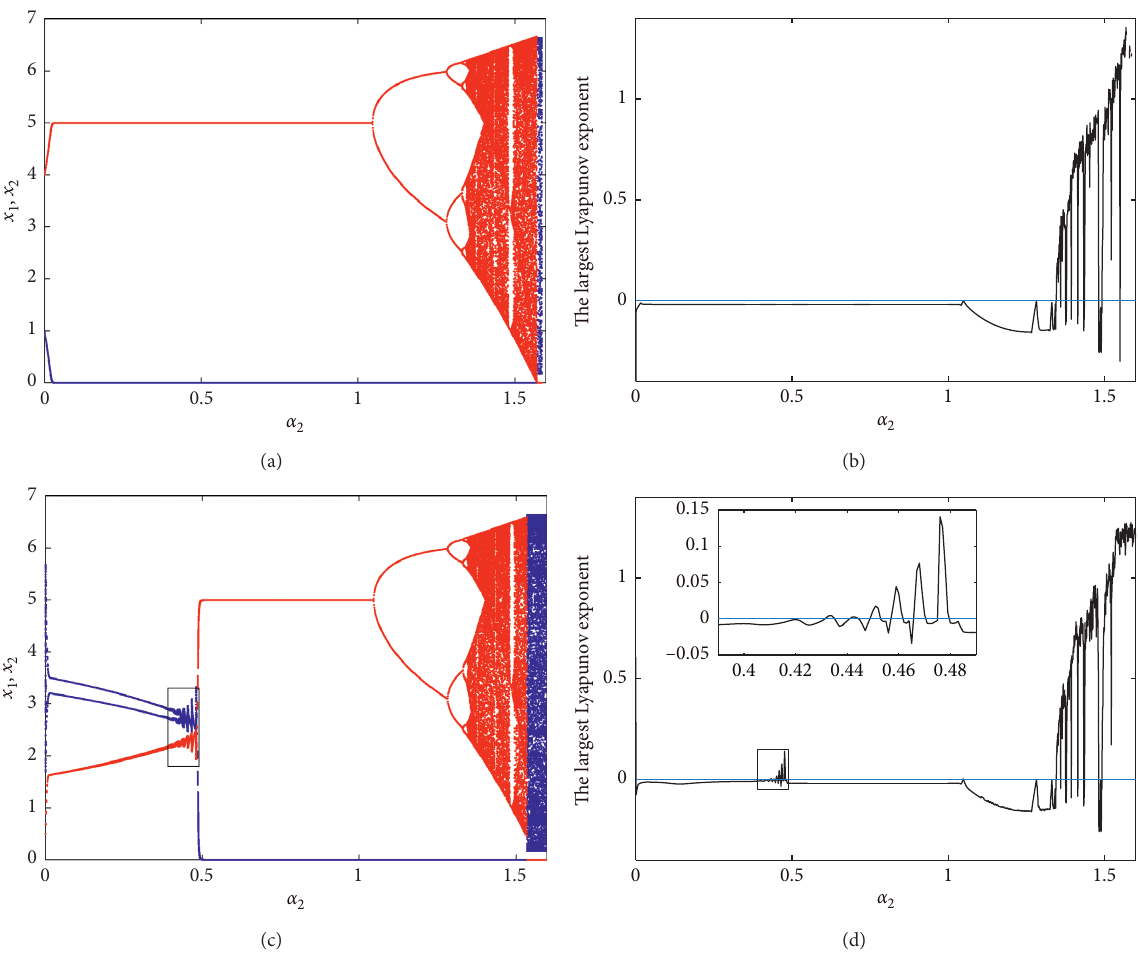
Figure 5: The bifurcation of system (10) with respect to parameter α largest Lyapunov exponent to Figure 5(a). (c) The initial value is given as ( x exponent to Figure